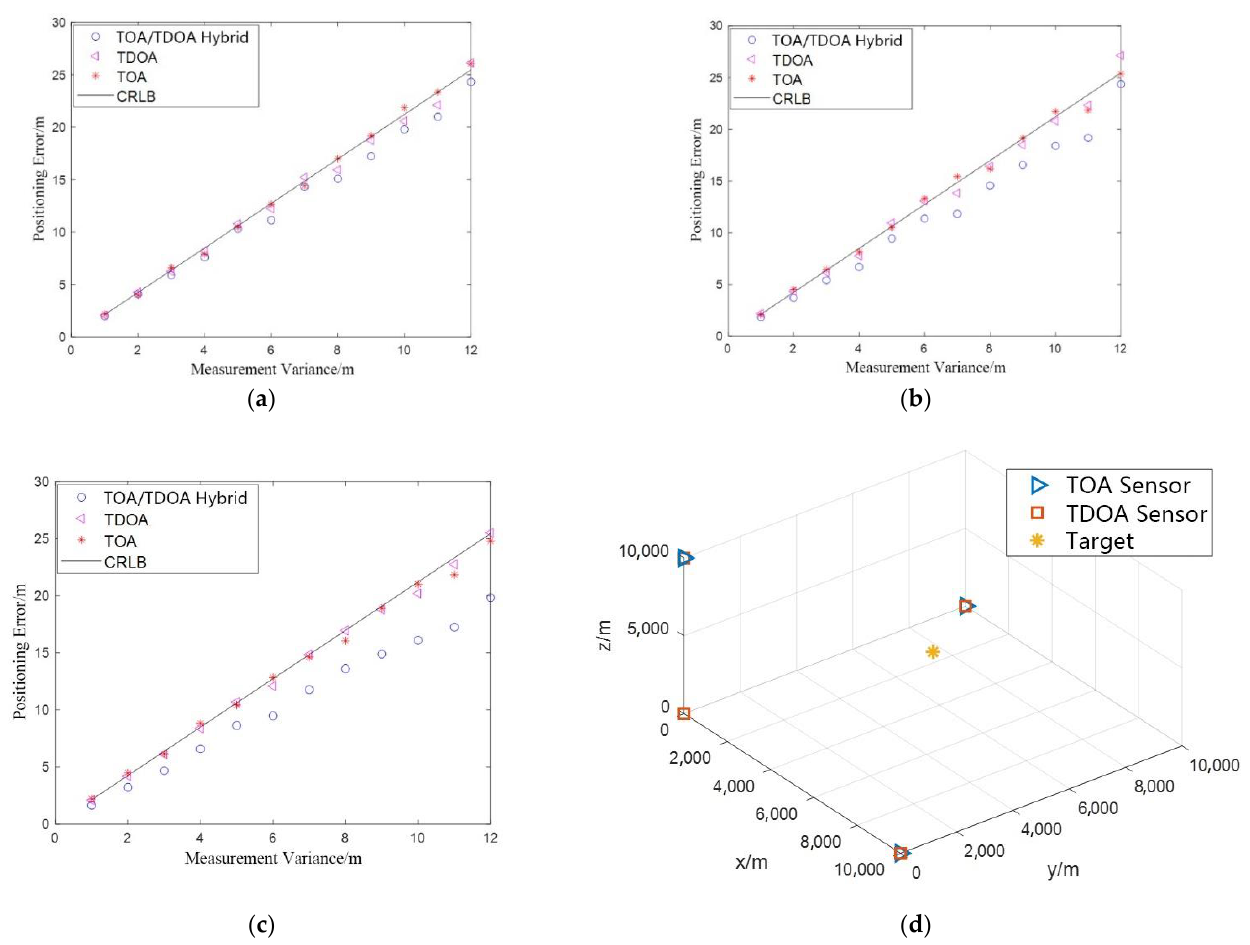
Figure 2. TOA/TDOA hybrid positioning simulation curve based on Gauss – Newton method: ( a ) Simulation results for 1-TOA sensor and 4-TDOA sensors; ( b ) Simulation results for 2-TOA sensor and 4-TDOA sensors; ( c ) Simulation results for 3-TOA sensor and 4-TDOA sensors; ( d ) Placement scheme for 3-TOA sensor and 4-TDOA sensors.